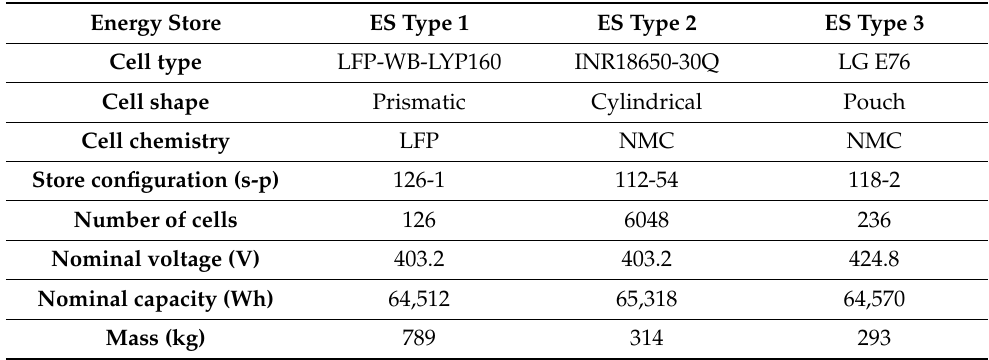
Figure 4. Configuration of the electric drive system with four electric motors installed in the wheels of the vehicle and inverter on board the vehicle. PE—Power Electronics (Inverter), WHM—Wheel Hub Motor. Table 1. Energy storage parameters.